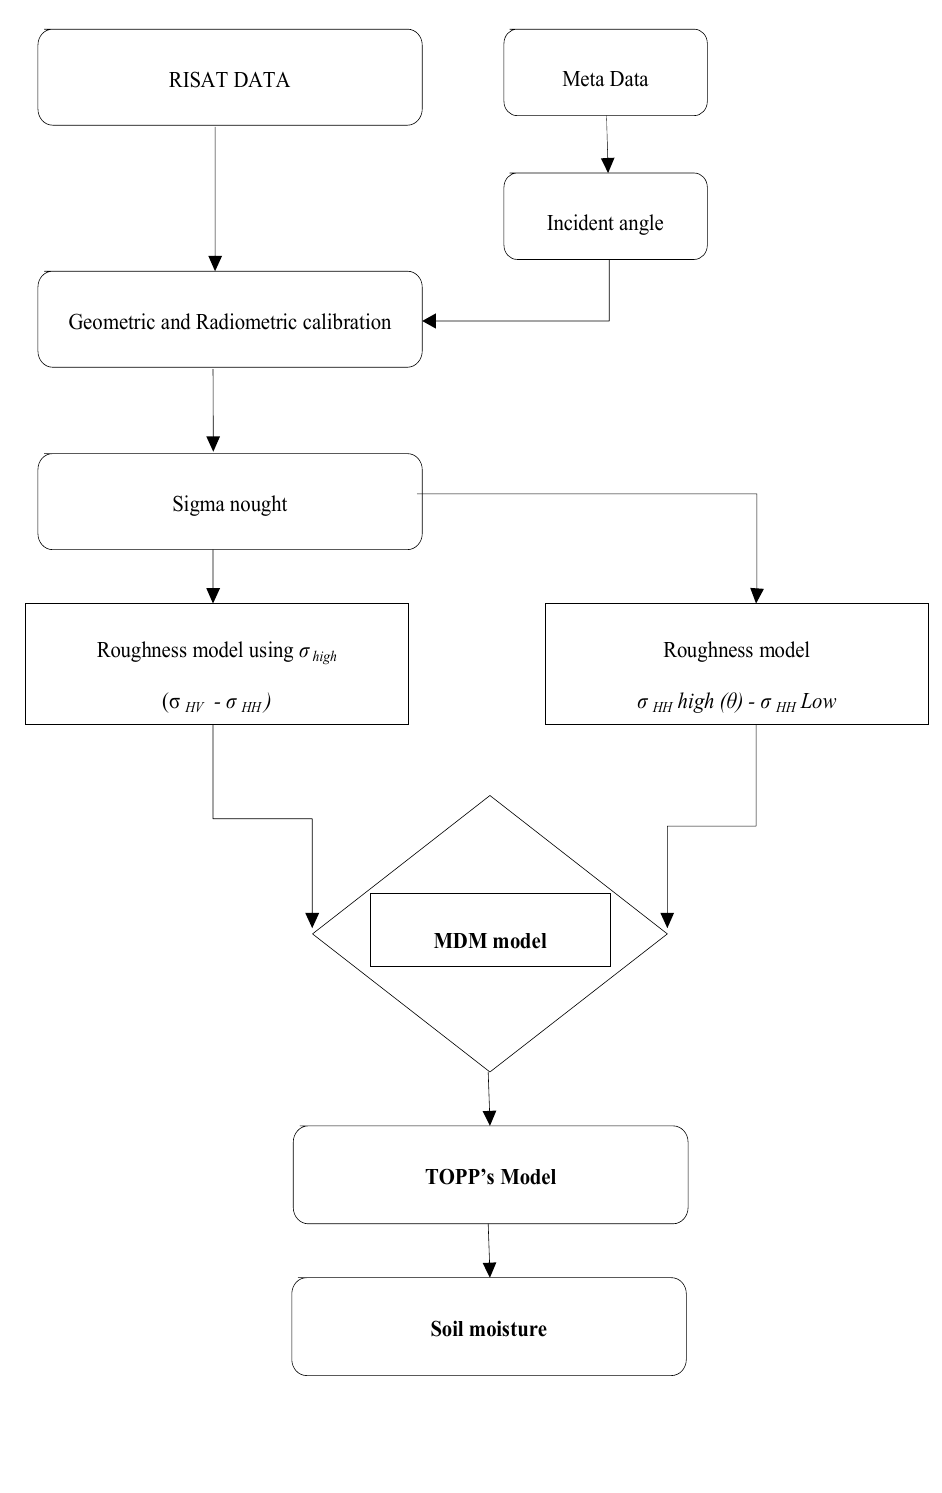
Figure1. Procedure followed in this